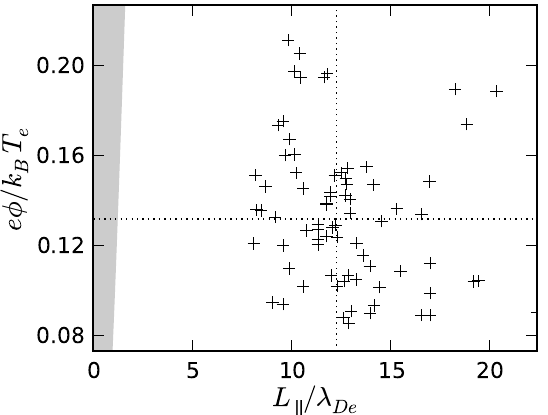
Fig. 5. Amplitude and half parallel width of the solitary structures from a single experiment, with B = 750G, n e = 5 . 8 × 10 9 cm − 3 , T e = 0 . 2eV and a beam voltage of 120V. The shaded area corresponds to a theoretically inaccessible area of the parameter space for stationary 3-D electron-holes (Chen et al., 2005). The dotted lines indicate the median values.